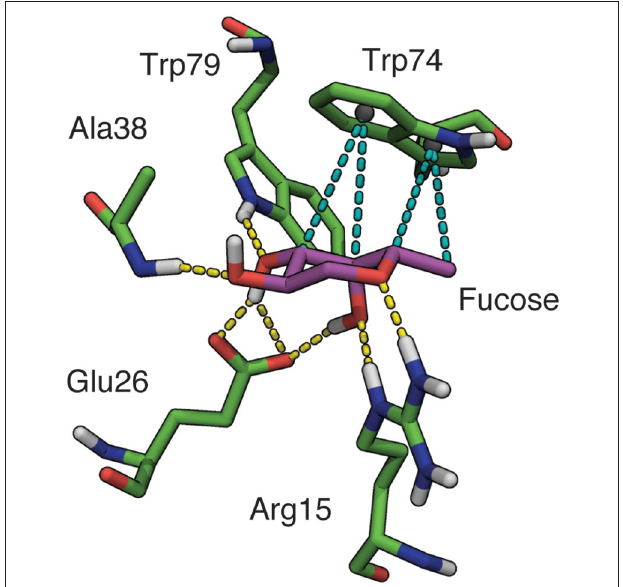
FIGURE 3 | Binding site interactions involving fucose in BambL-blood group saccharide docked poses. Hydrogen bonds shown as yellow dashes, hydrophobic interactions shown as teal dashes. Non-polar hydrogens omitted for clarity.